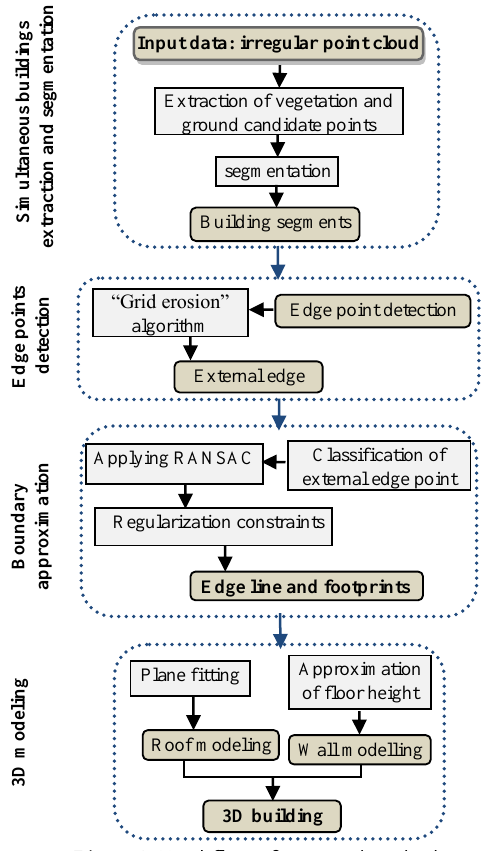
Figure 1. Workflow of proposed method edge point detection, boundary approximation, and 3D